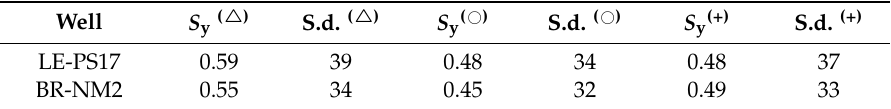
Table 2. S y values resulting from least-square regression of Figures 3 and 4 (slopes of the regression lines) and residual standard deviation values; ( (cid:52) ) no corrections applied, ( ) with correction of (cid:35) Equation (1) and disaggregated values, (+) with correction of Equation (1) and aggregated values. ) S.d. ( ) S y(+) S.d. (+) Well S y ( (cid:52) ) S.d. ( (cid:52) ) S y( (cid:35) (cid:35) LE-PS17 0.59 39 0.48 34 0.48 37 BR-NM2 0.55 34 0.45 32 0.49